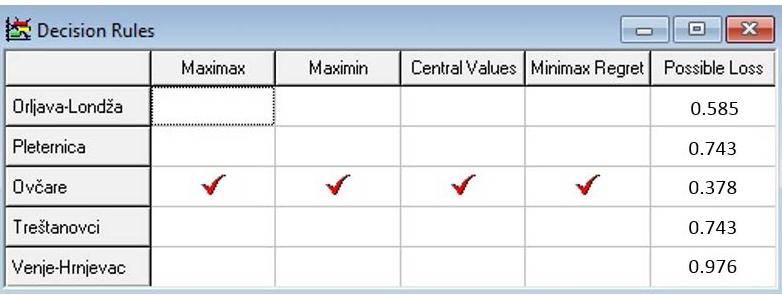
Figure 11. Advised alternative for decision maker for Scenario 1. Using Scenarios 1, 2, and 4 (from Table 3) all the results suggest that the first alternative to be implemented should be Ovča re, followed by Orljava– Londža, Pleternica, Trešta novci, and as the last one Venje–Hrnjevac. Results based on Scenario 3 suggest that the first alternative to be implemented should be Orljava– Londža, followed by Ovčare, Pleternica, Treštanovci , and Venje–Hrnjevac. 3.6. PCA Input data for PCA are adopted from Table 1 by introducing mark “2” instead of “best” and mark “1” instead of “worst” and based on Scenario 1 from Table 3. Application of PCA defined three key factors, and each of them is a combination of several criteria (Table 9). The contribution of key factor F1 is 44% and it consists of two criteria: environmental protection and recreation. Contribution of key factor F2 is 37%. It is a combination of four criteria: drainage, irrigation area, reservoirs, and time for completion. The third key factor F3 has a contribution of 19% with the contribution of two criteria: cost/unit area and channel network. Table 9. Factor loadings according to PCA (Principal Component Analysis) for Scenario 1. F1